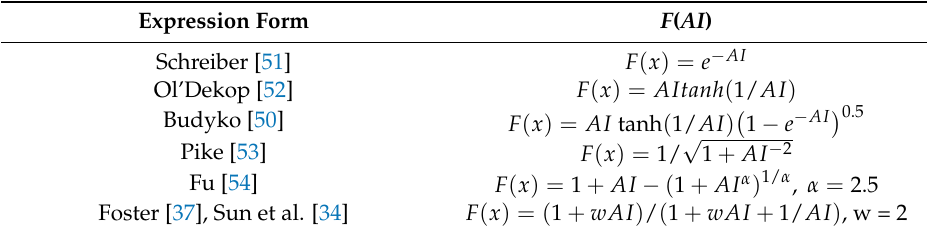
Table 2. A summary of methods for estimating annual actual evapotranspiration based on the Budyko Hypothesis.